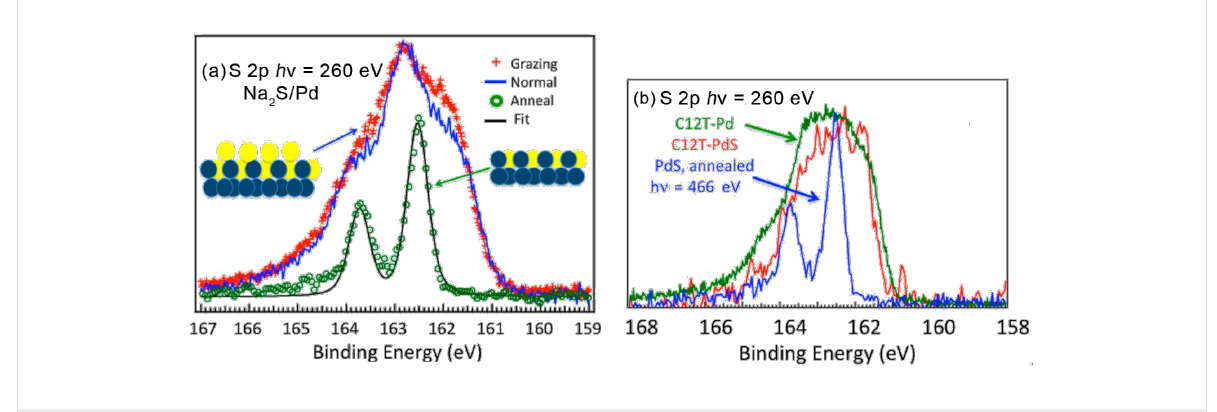
Figure 3: (a) XPS spectra [48] in the S 2p region before (blue, normal emission; red, grazing emission) and after annealing at 450 °C (green line). (b) Comparison of S 2p spectra [48] for the √ 7 PdS surface after annealing (blue line), PdS with adsorbed C12T molecules (red line), and clean Pd(111) with C12T molecules (green line). Figure adapted with permission from [48], copyright 2014 American Chemical Society.